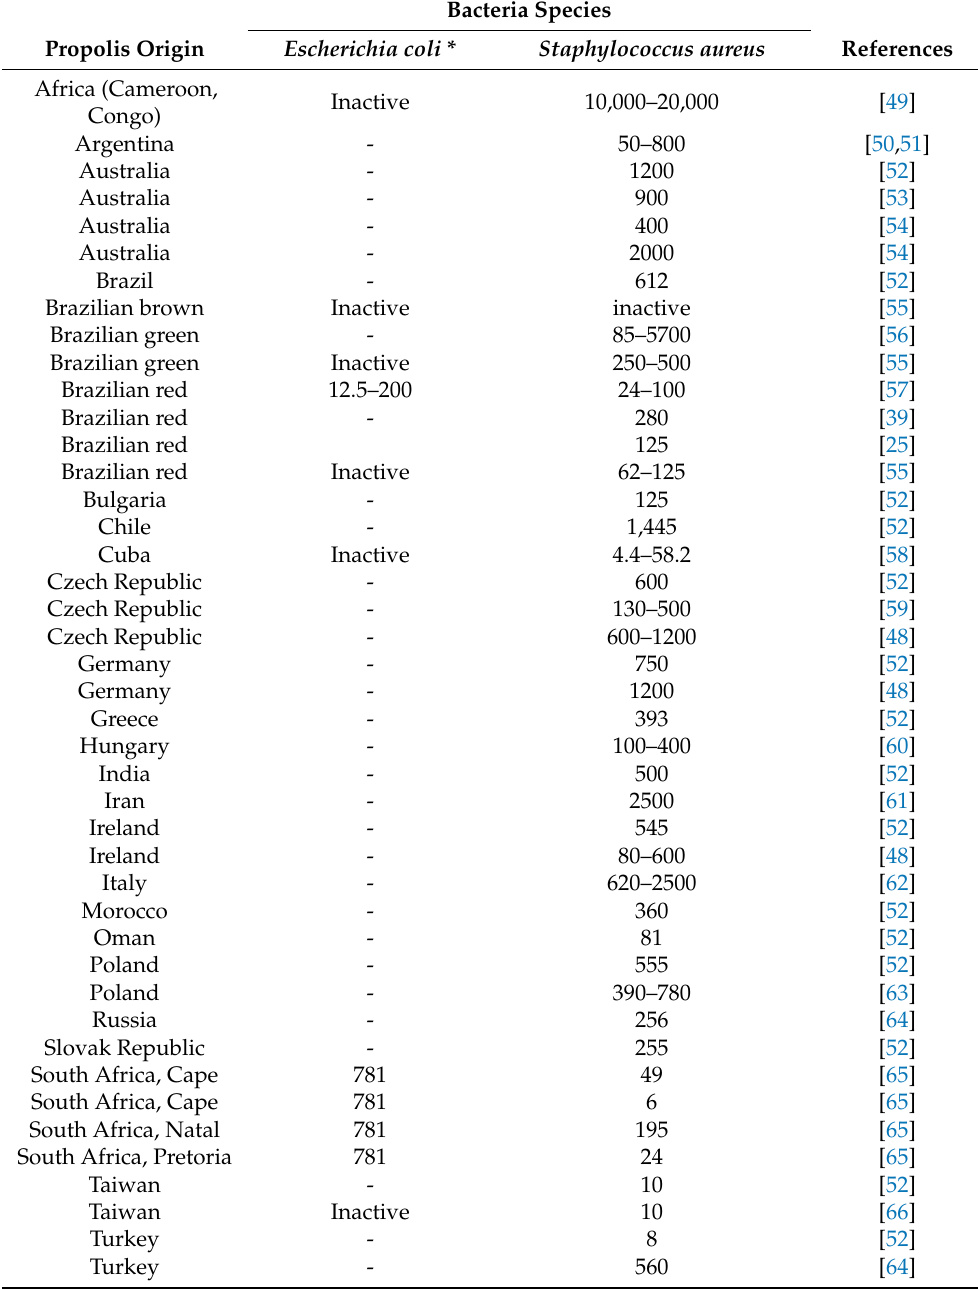
Table 1. Values of minimal inhibitory concentration (MIC 50 , µ g mL − 1 ) of ethanol extracts, against two species of bacteria, of propolis from several regions of the